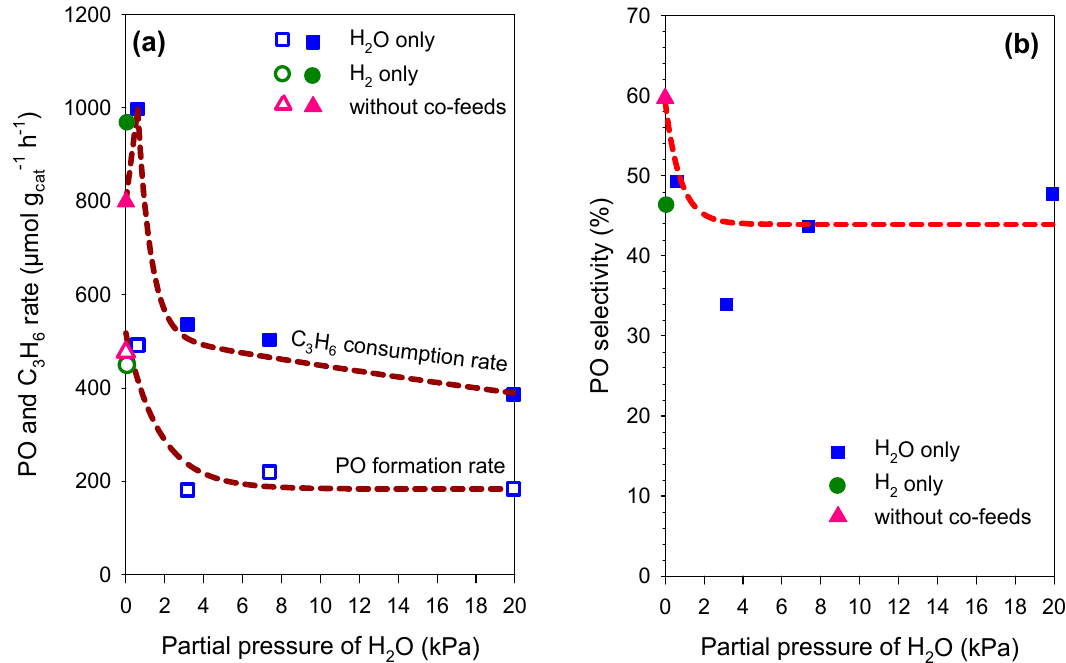
Figure 9. The influence of H 2 O vapor pressures on ( a ) the C 3 H 6 consumption rate and PO formation rate and ( b ) PO selectivity. Reproduced with permission from [27] .